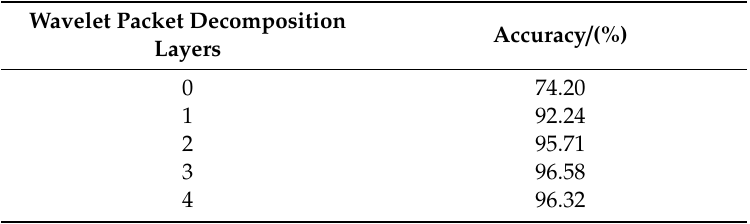
Table 4. Comparison results of wavelet packet decomposition layers.